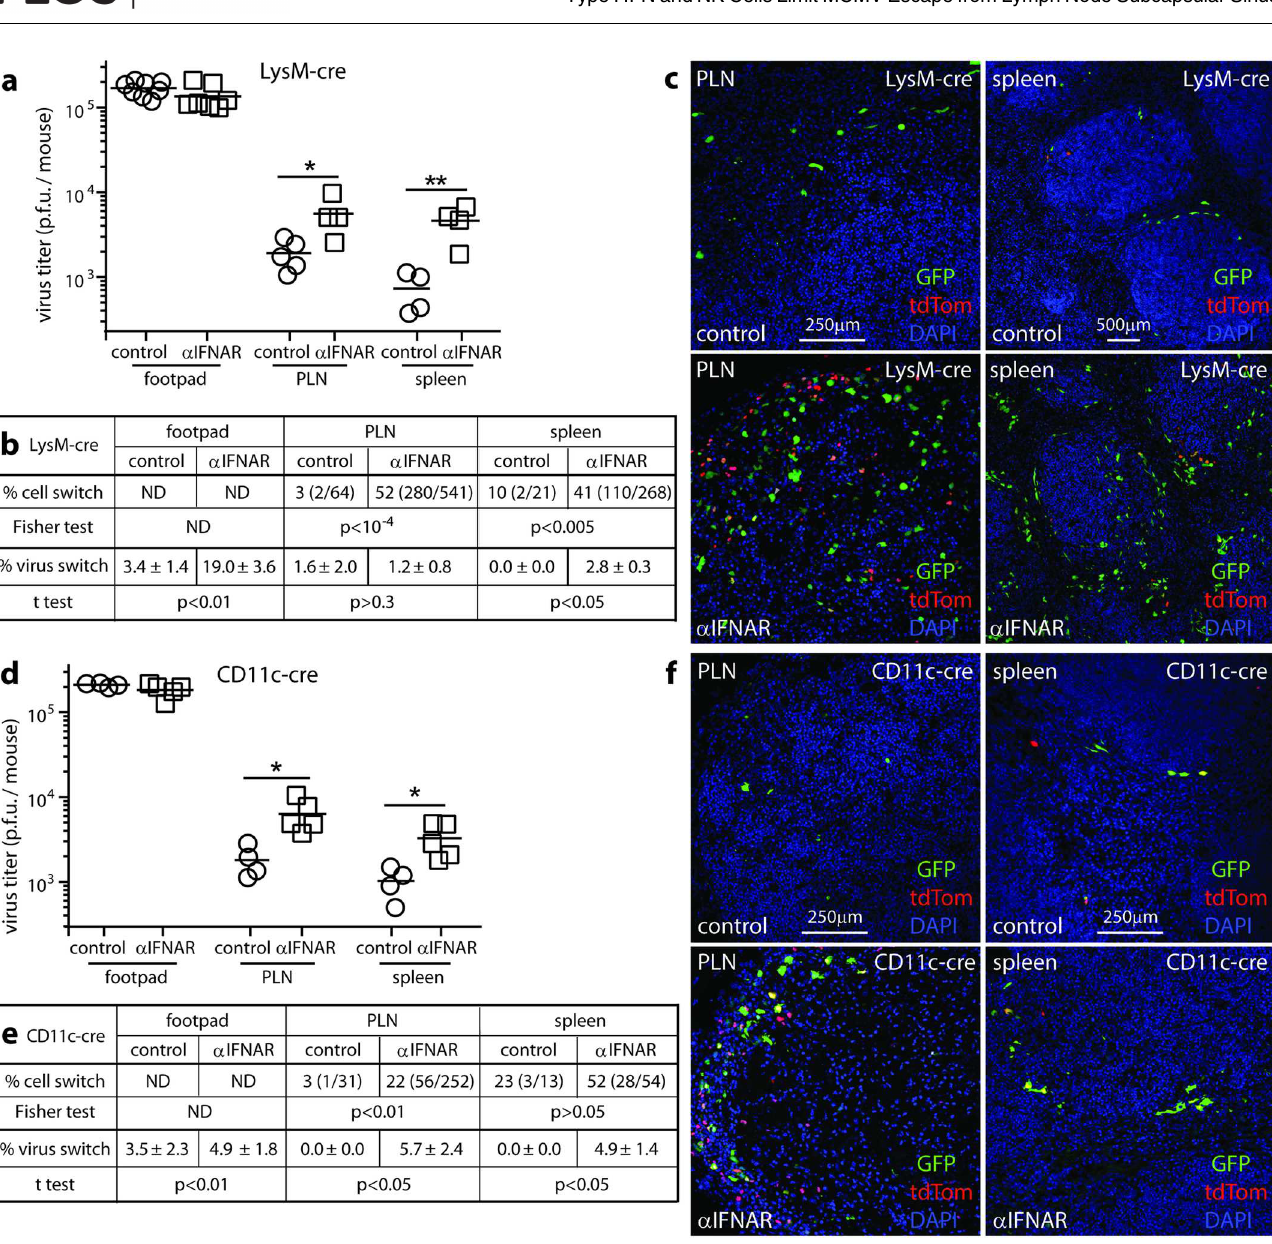
Fig 9. Non-myeloid cells produce most of the infectious virus in IFNAR-blocked mice. (a,d). LysM-cre ( a-c ) or CD11c-cre mice ( d-f ) were given IFNAR blockingantibody( α IFNAR) or not (control) then MCMV-GR i.f. (10 6 p.f.u.). Footpads, PLN and spleens harvested3 days later were plaque assayed for infectiousvirus. Squares and circles show individuals,horizontalbars show means. Significant differencesare indicated(Student’stwo tailed unpairedt-test; * p < 0.05, ** p < 0.01). (b,e). Switched(red) and unswitched (green)infected cells were countedon PLN and spleen sectionsfor 5 fields of view per mouse from each of 4 mice per group. The numbers give the % cell switchingand in parentheses the switchedand total infected cell counts. The switching rates α IFNAR and control mice were comparedfor each site by Fisher’s Exact Test. We also determinedbelowthe % virus switching(infectious) recoveredfrom each mouse. The numbers give mean ± SEM for each group. The α IFNAR and control results were compared (Student’s two tailed unpairedt test). (c,f). Exampleviral GFP and tdTomato staining is shown for infected PLN of control and α IFNAR mice. Nuclear DAPI stainingshows the loss of cellularityin PLN of α IFNAR